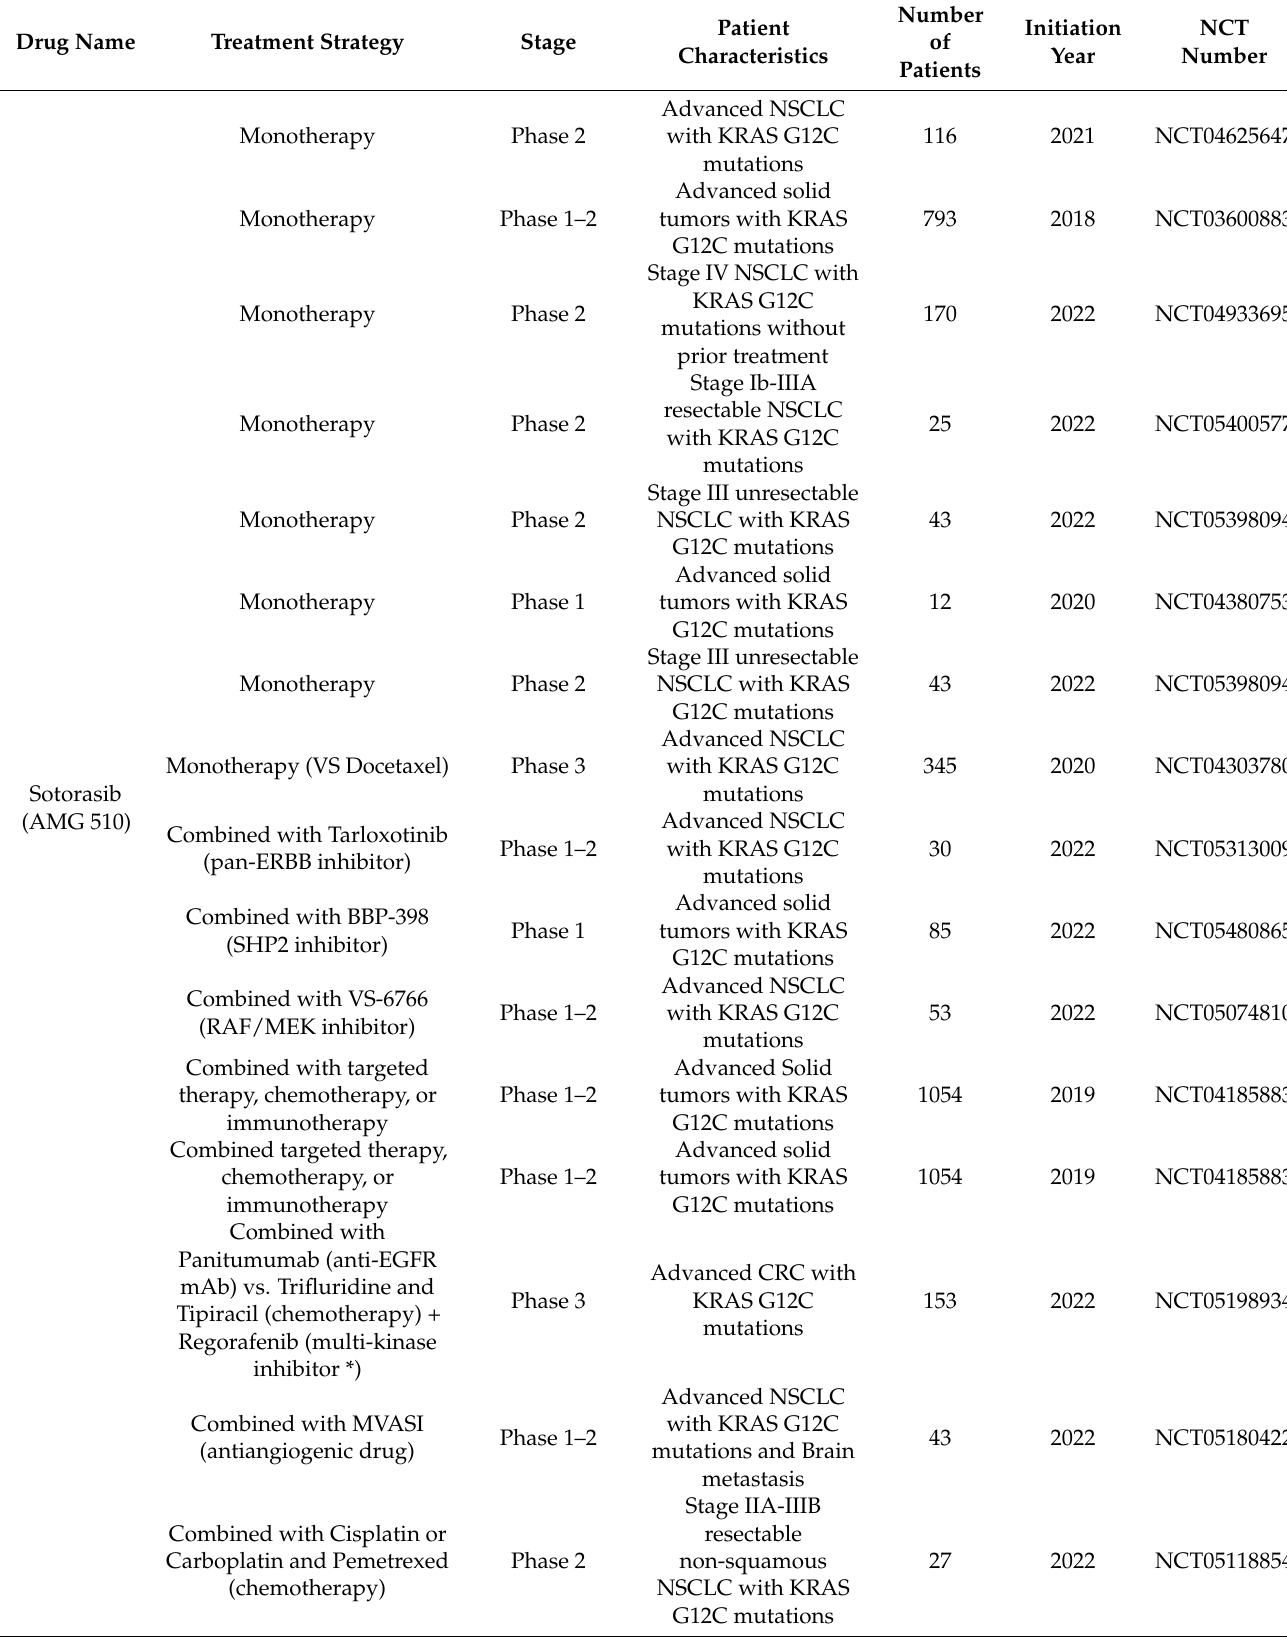
Table 2. Clinical Trials of KRAS G12C-Targeted Therapy on KRAS Mutant